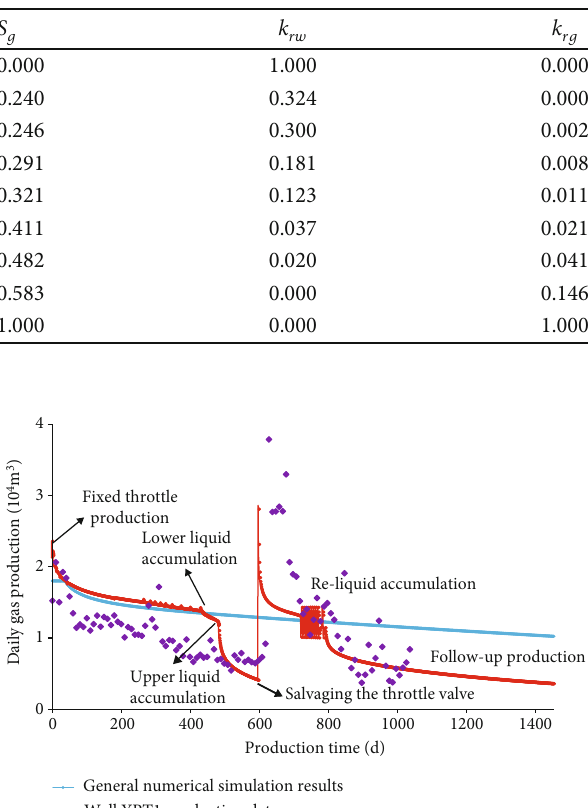
Table 2: The relative permeability of gas